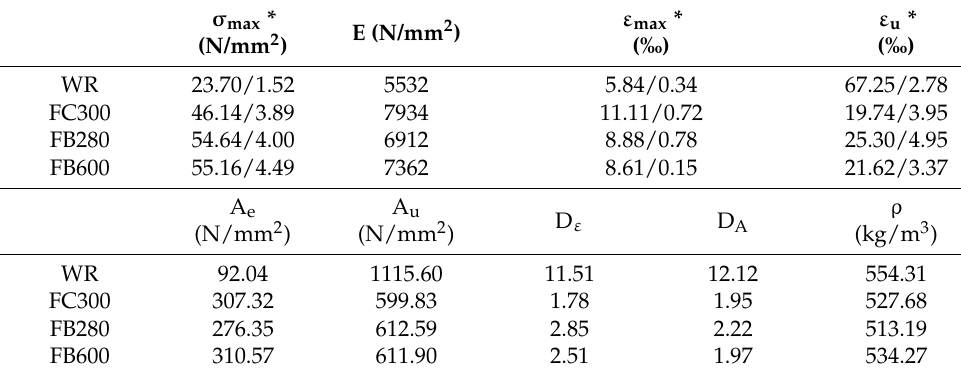
Table 2. Average density and results obtained in compression tests up to breaking